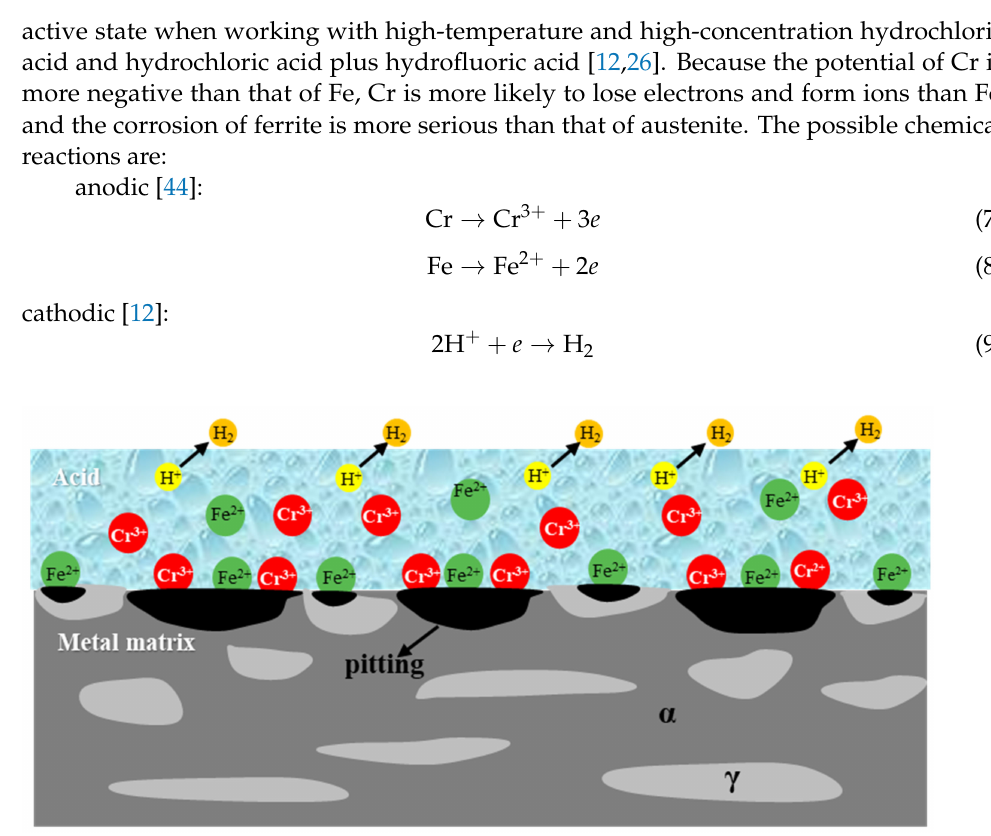
Figure 18. Corrosion mechanism of duplex stainless steel in high-temperature and high-concentration acid solution